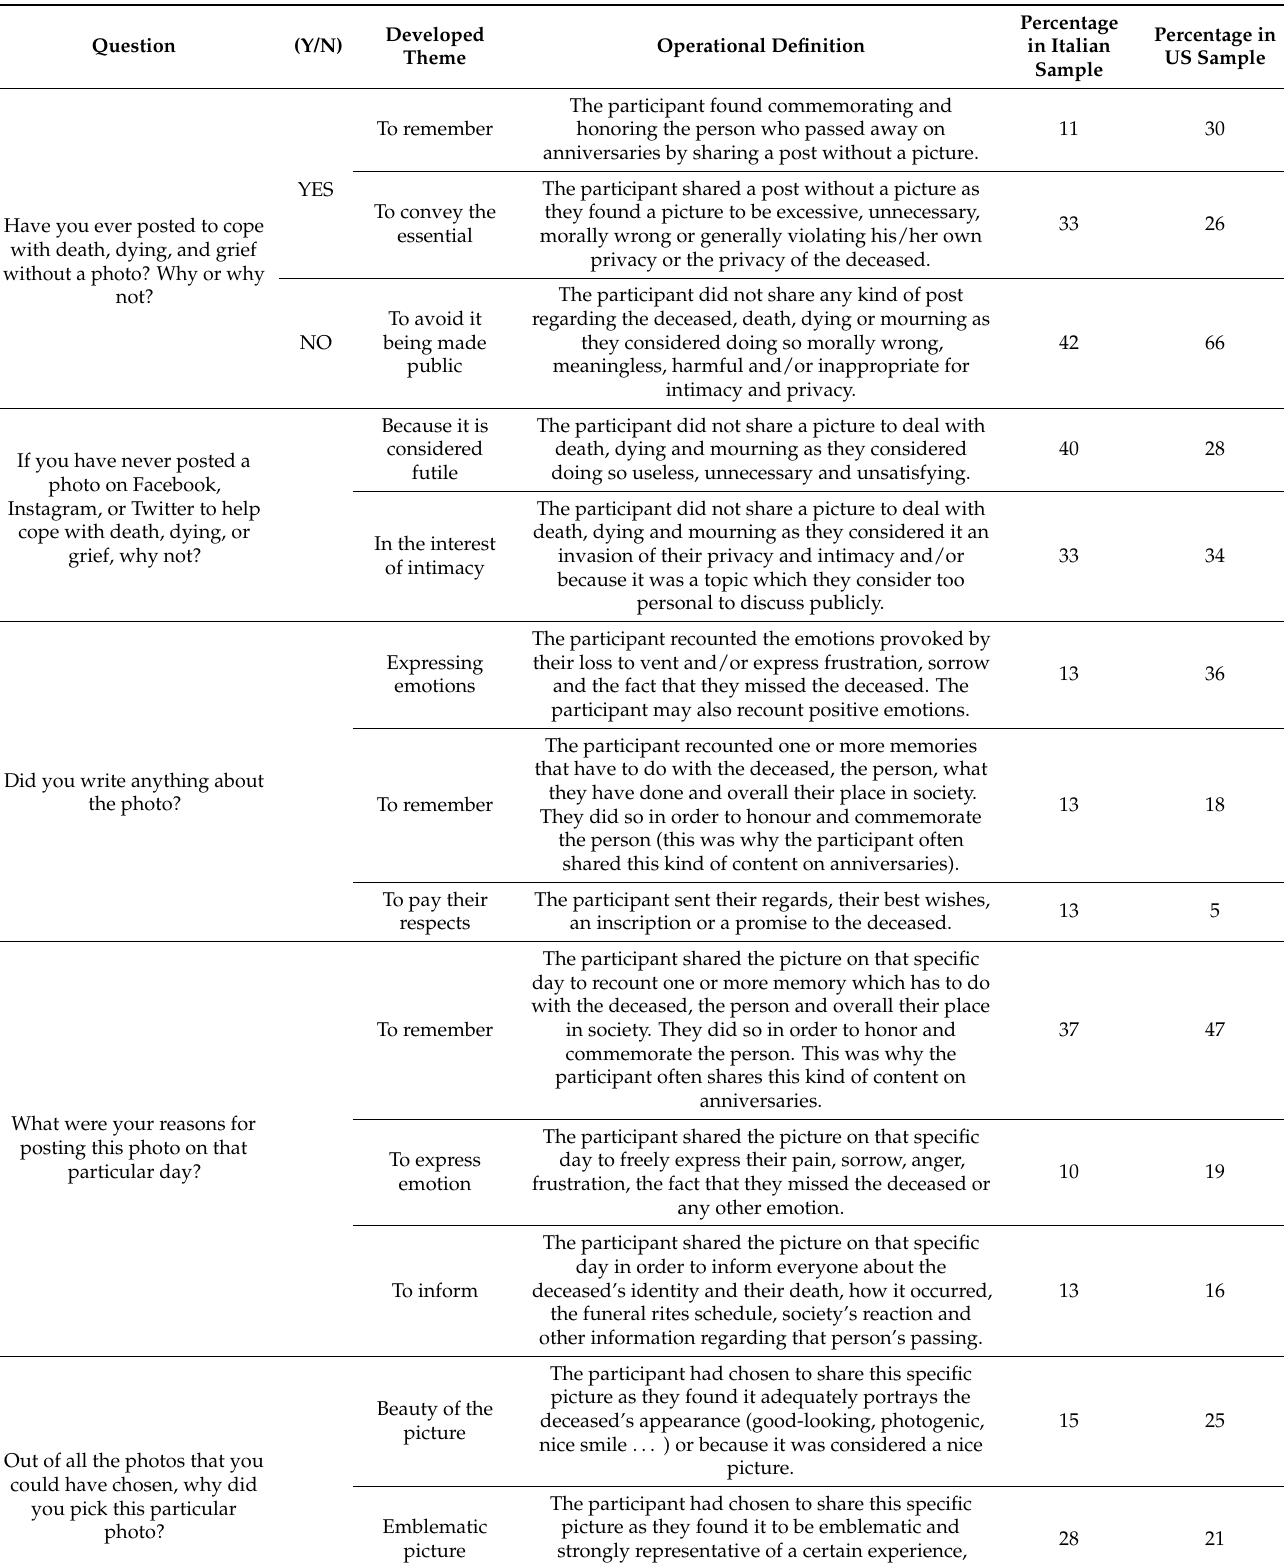
Table 3. Percentage of the main codes found in response to the open ended